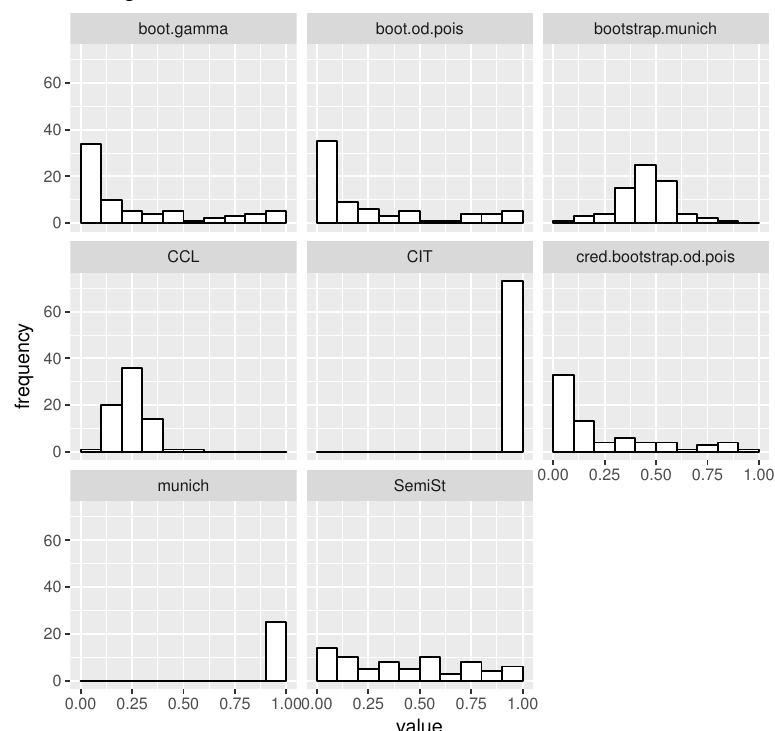
Figure 3. Histograms of PIT values from the private passenger auto liability